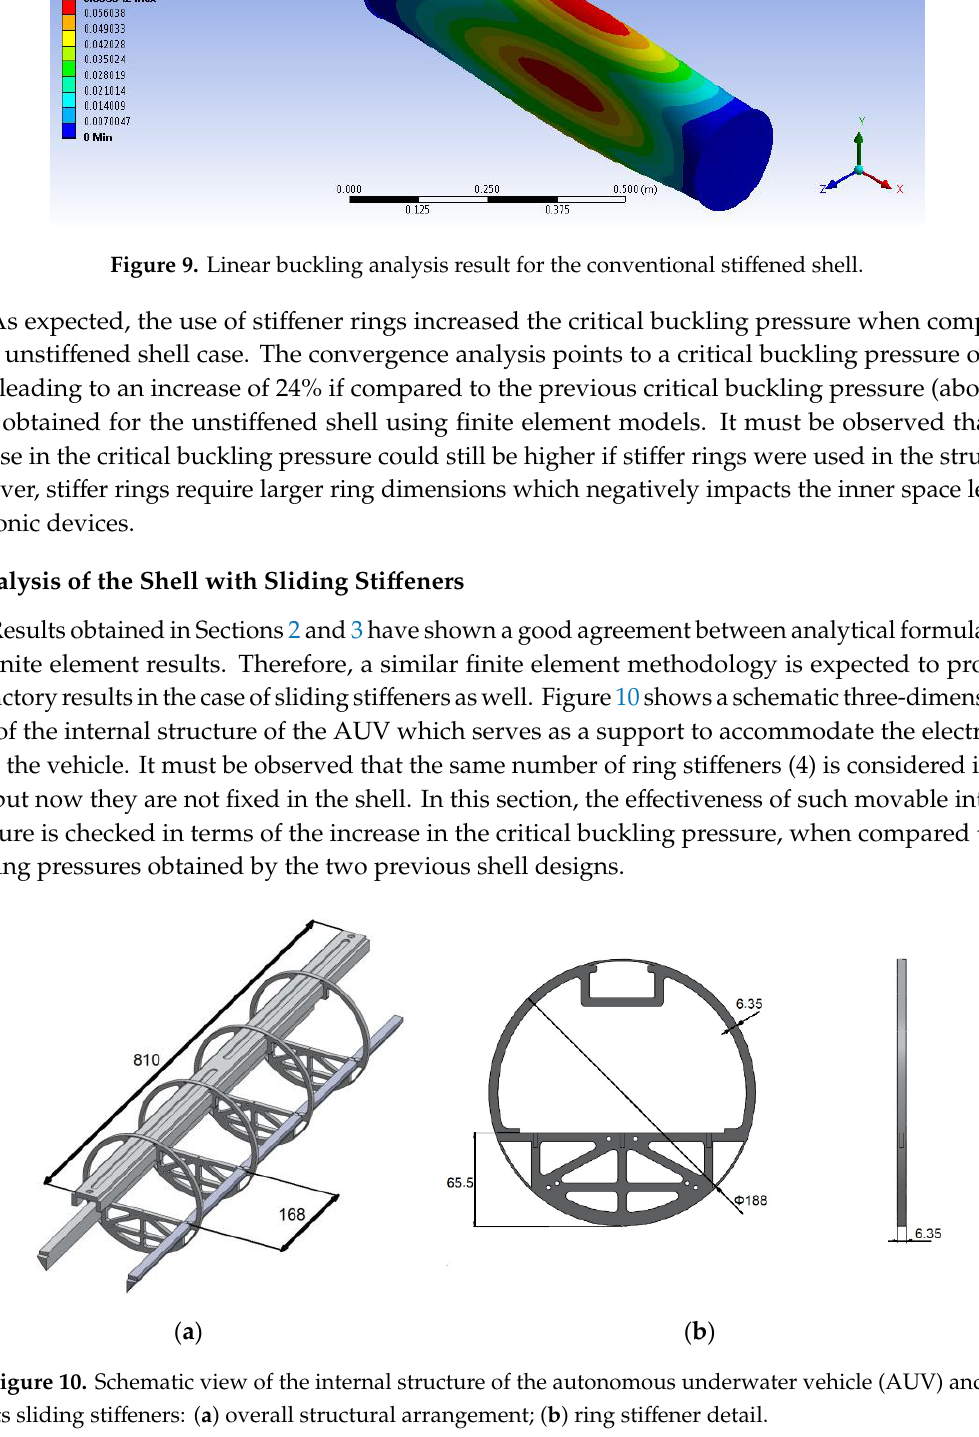
( b ) Figure 11. Geometries considered in the analyses: ( a ) four conventional stiffeners rigidly attached to the shell (Section 3), ( b ) shell with sliding stiffeners regularly spaced along the shell. It must be observed that, for this new shell design, gap formation between some parts of the shell and parts of the ring stiffeners does occur (after buckling) since the ring stiffeners are not fixed to the shell. A friction coefficient of μ = 0.2 between shell and stiffeners was used in all the analyses of this section. Figure 12 shows all the elements that were used to represent the sliding stiffeners in the finite element analysis (the longitudinal members were erased in Figure 11 to make it clearer).